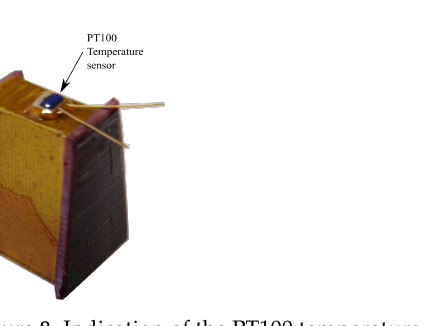
Figure 8. Indication of the PT100 temperature sensor